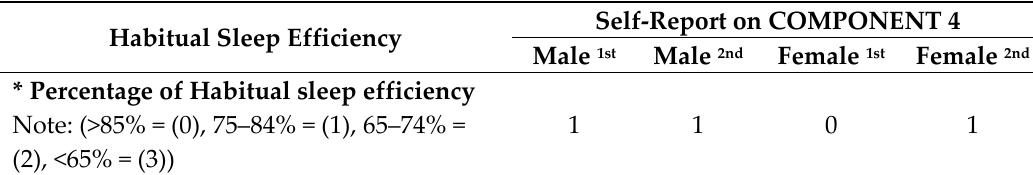
Table 4. Component 4 of the PSQI on the 4 flight